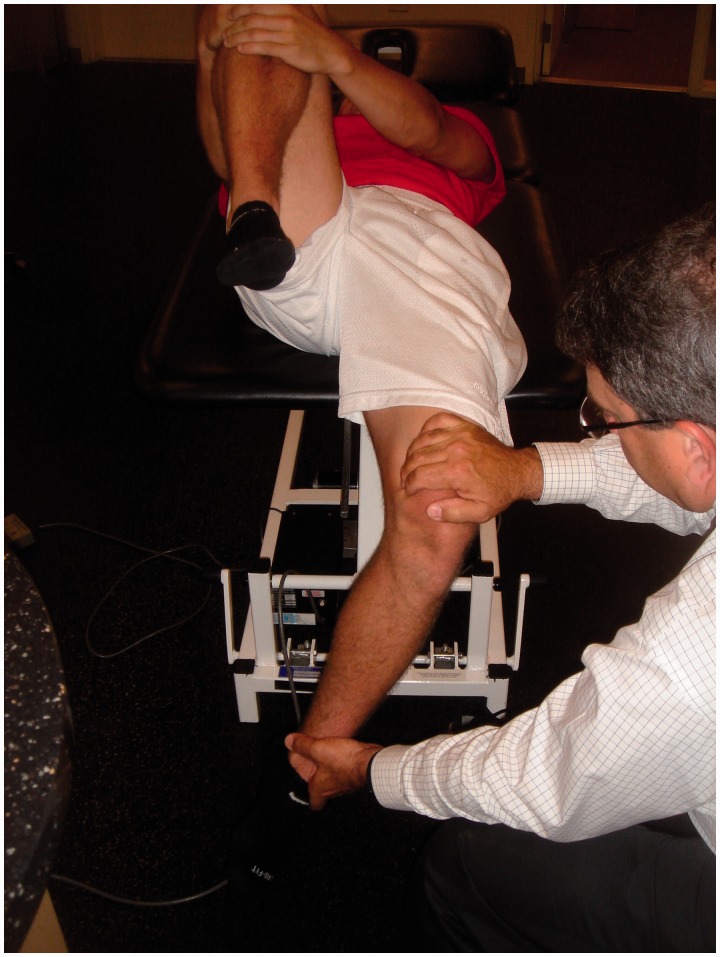
Anterior apprehension test. Also known as the hyperextension—external rotation test. The subject is positioned at the end of the examination table. The patient holds one knee with the hip in flexion, while the other hip is allowed to extend over the end of the table. The examiner then externally rotates the extremity. Anterior hip pain is consistent with anterior labral tear and/or anterior hip instability. Posterior hip pain may be present with posterior hip impingement.